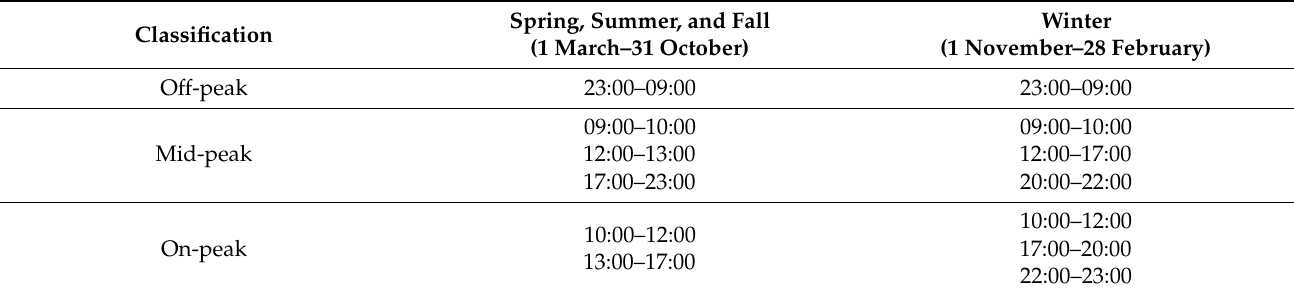
Table 1. Electricity rate schedules for season and time